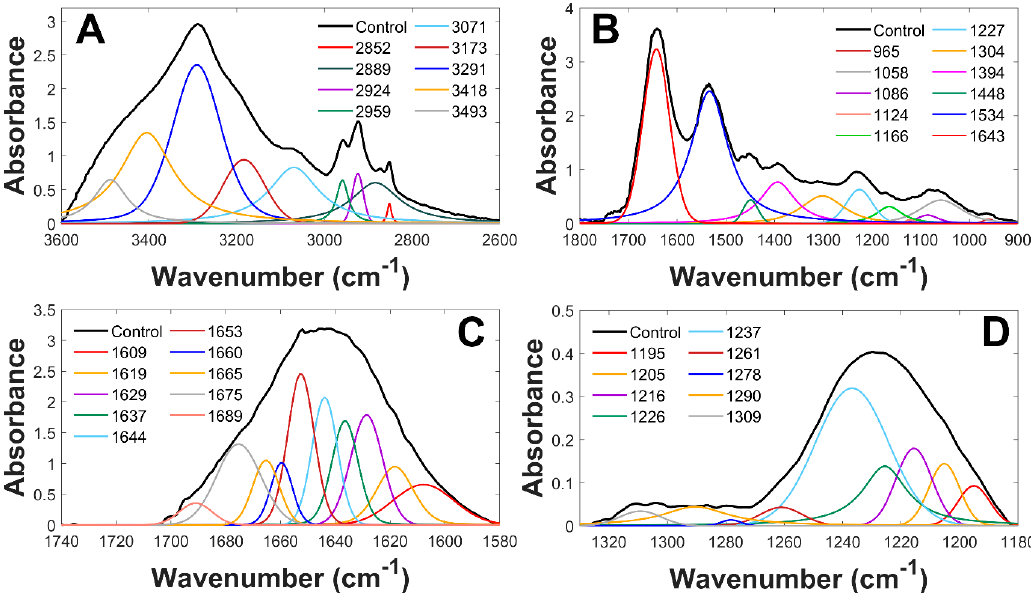
Figure 2. Deconvolution of average control spectra ( A ) in the high wavenumber region (3600–2600 cm − 1 ), ( B ) in the fingerprint region (1800–900 cm − 1 ), ( C ) in the Amide I band region (1740–1580 cm − 1 ) and ( D ) in the Amide III band region (1350–1180 cm − 1 ).